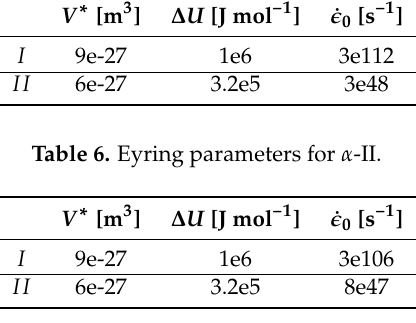
Table 7. Eyring parameters for γ